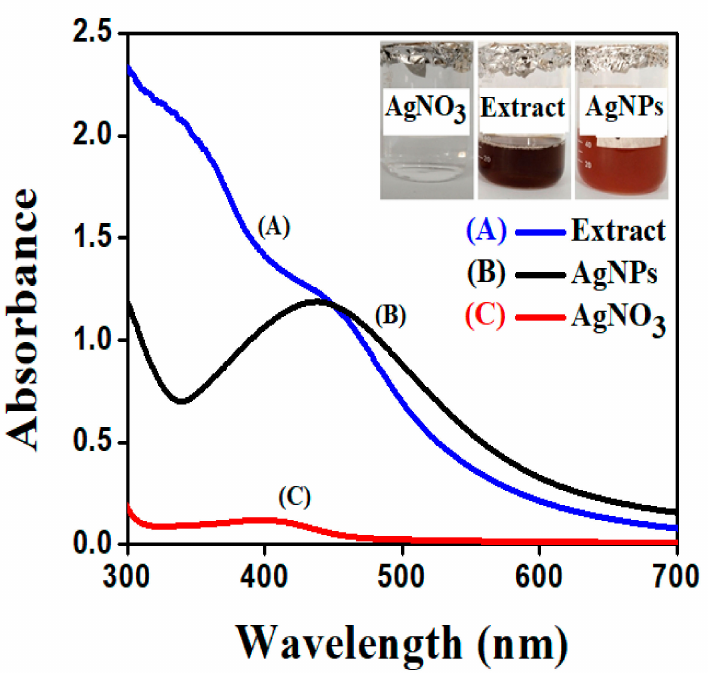
Figure 1. UV-Visible spectra of: ( A ) Pure extract of S. procumbens ; ( B ) Synthesized AgNPs; and ( C ) 0.01 mol/L solution of AgNO 3 .